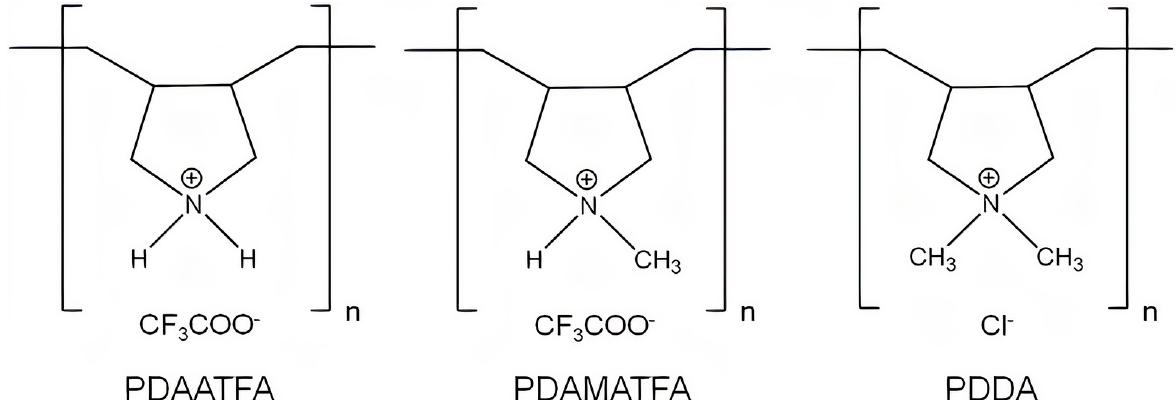
Figure 7. Chemical structures of some PDDA derivatives with increasing hydrophobic–hydrophilic balance from left to right. Polymers are poly (diallylammonium trifluoroacetate) (PDAATFA), poly (diallylmethylammonium trifluoroacetate) (PDAMATFA) and poly (diallyldimethylammonium chloride) PDDA. Reproduced from [17].